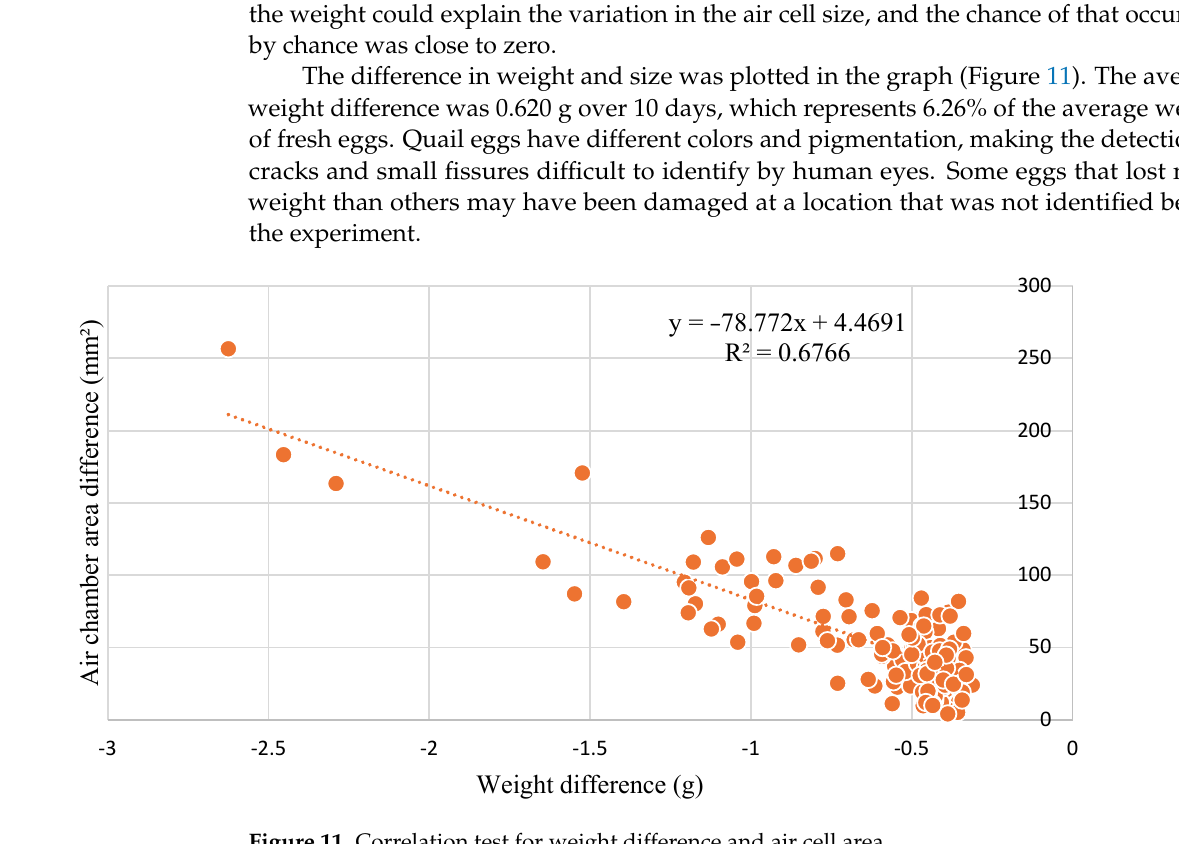
Figure 11. Correlation test for weight difference and air cell area.